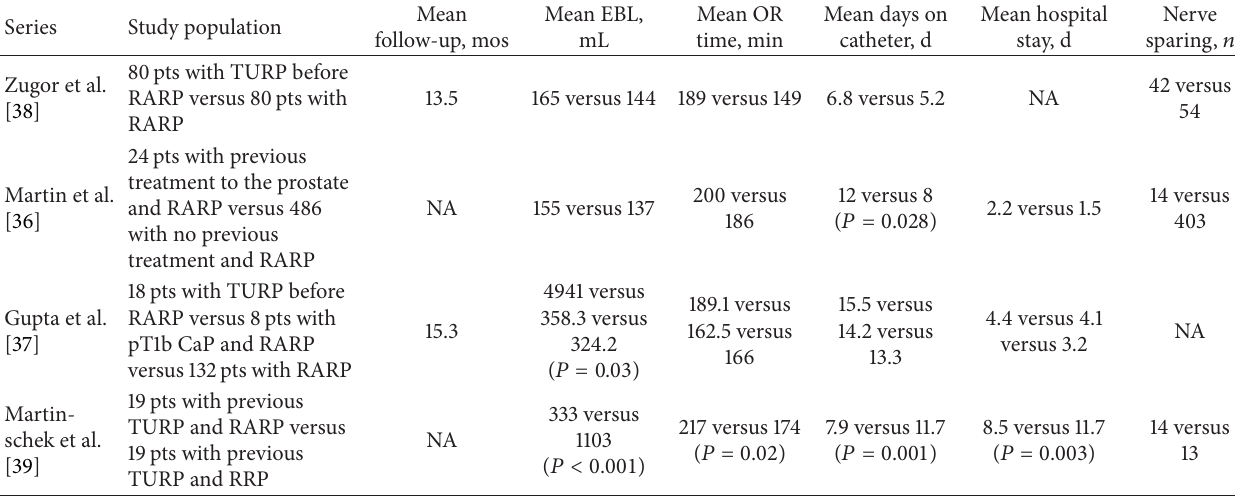
Mean Mean EBL, Mean hospital follow-up, mos